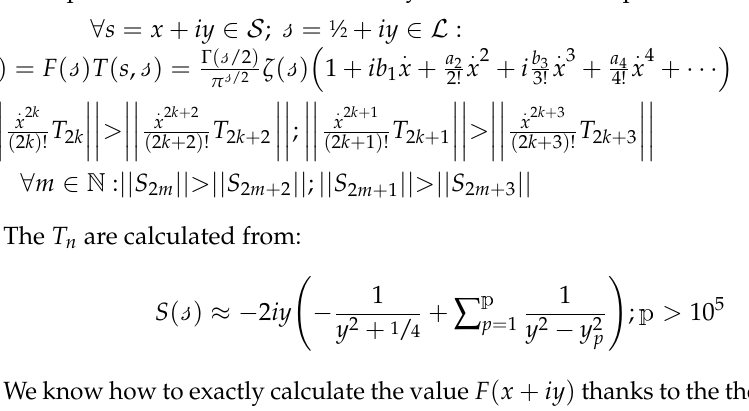
Figure 9. Exact F (blue and red) and estimate of F (lawn-green and brown) on a cross-section of CS from a point on the CL, using the Taylor series: ( a ) real part; ( b ) imaginary part. The approximate value corresponds well to the exact value. The approximation is less good when | x − 1 / 2 | increases. If the points Z and H have the same y-coordinate, the expression is